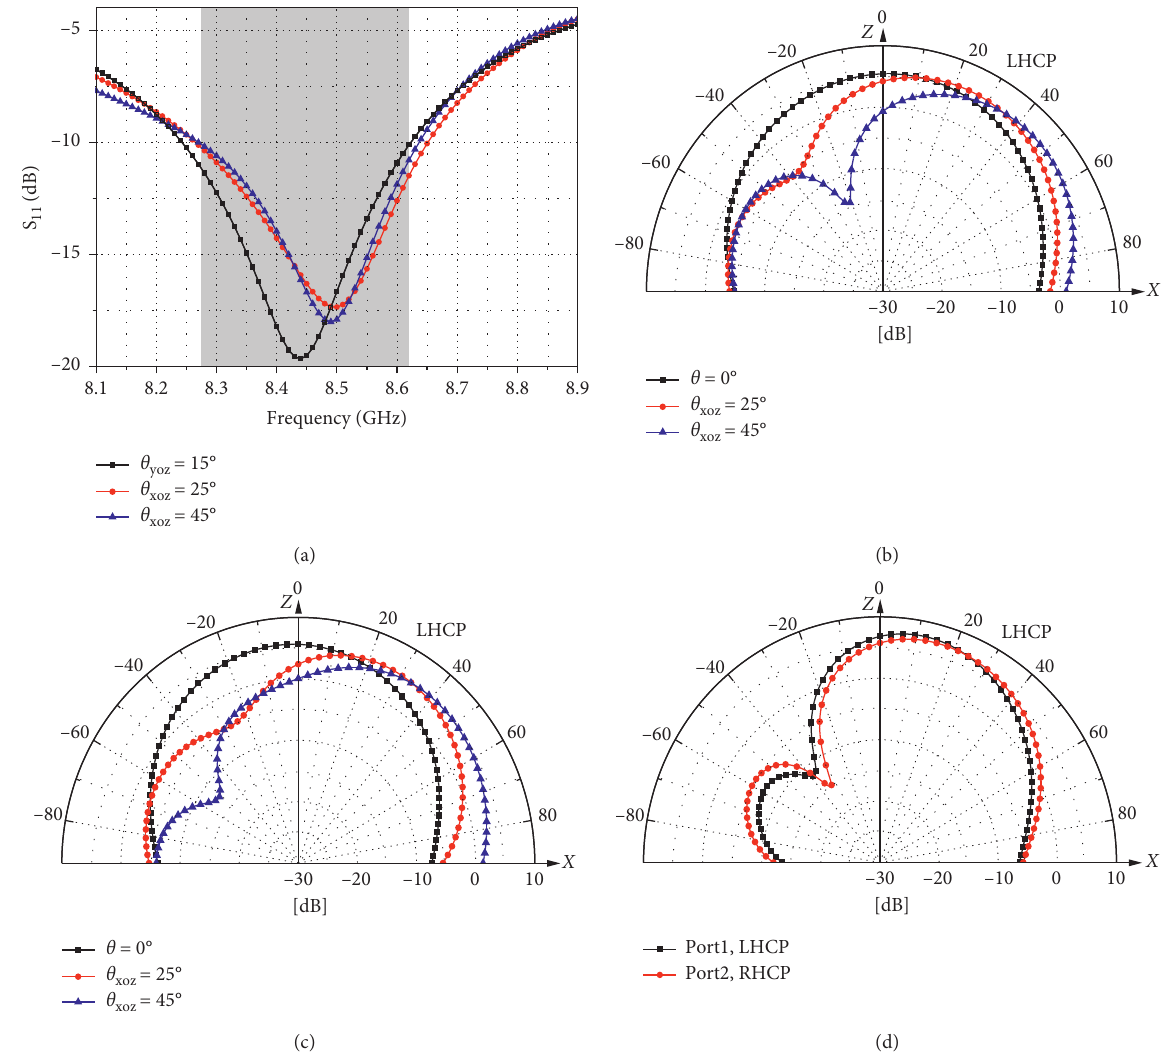
Figure 6: The simulated radiation patterns of different beam steering directions of the RPA. (a) S11. (b) xoz -plane, port 1. (c) xoz -plane, port 2. (d) yoz